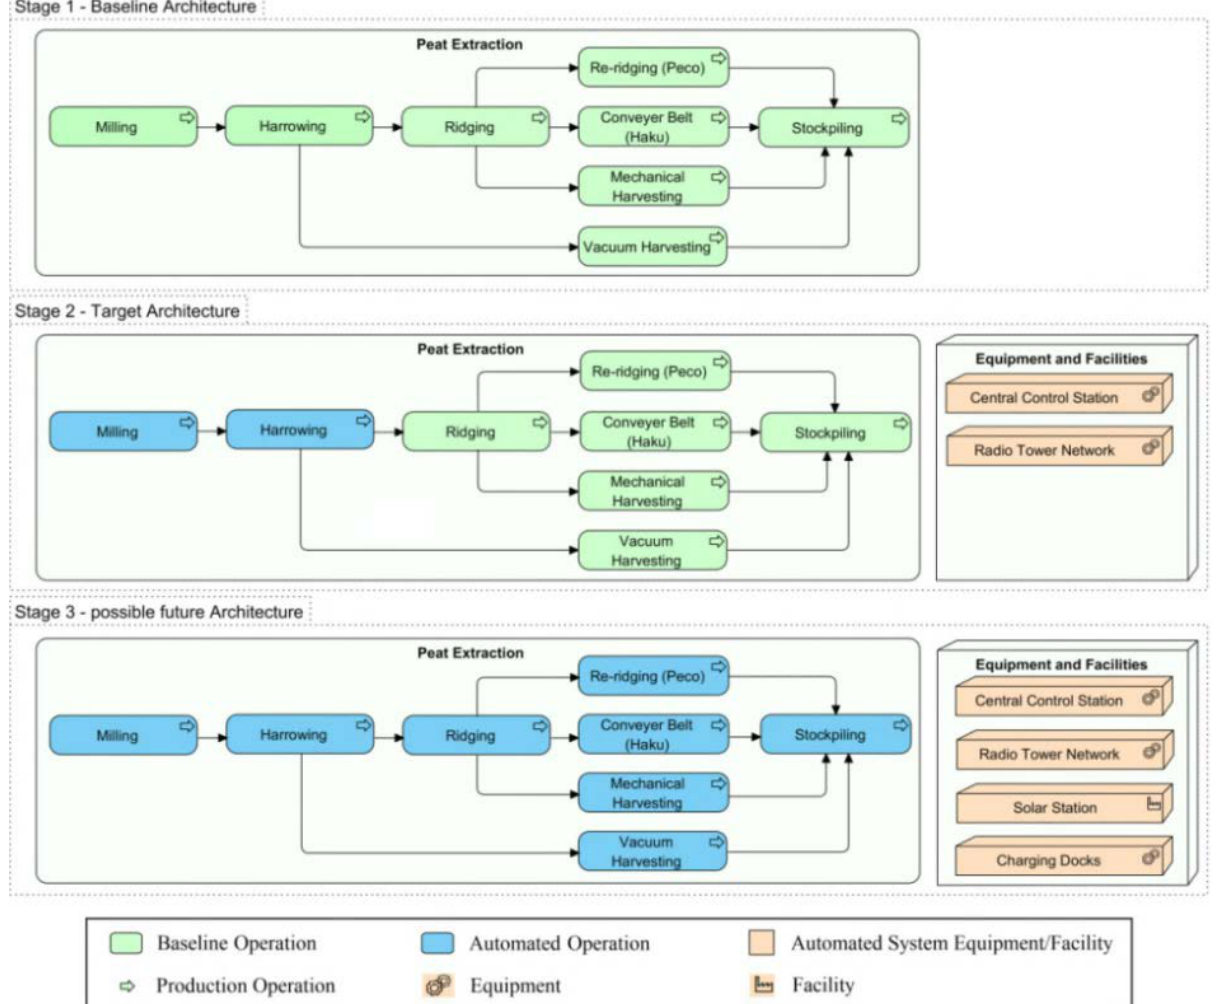
Figure 1. Evolution of baseline (Stage 1) and target (Stage 2) architecture of the robotic peat extraction system. After validation of the system architecture, automation of all peat extraction processes (Stage 3) will follow, but Stage 3 is not in scope for the present study and is not discussed any further in this article.